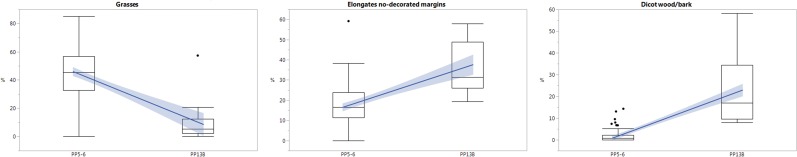
Comparison with PP13B.Box-Plots showing the distribution of grass, elongate without decoration margins, dicot leaf and wood/bark phytoliths among the different StratAggs from PP13B (Albert and Marean, 2012) (DB Sand 4c, Upper Roof Spall, Shelly Brown Sand and DB Sand 3 StratAggs) and PP5-6N (YBSR, LBSR, ALBS, SADBS and BBCSR StratAggs) sites. The median (mid-line), standard error ± (box), standard deviation (whiskers), outliers extended beyond the whiskers, and the trend line (or line of best fit) showing the confidence region for the fitted line are given for the four plant types.